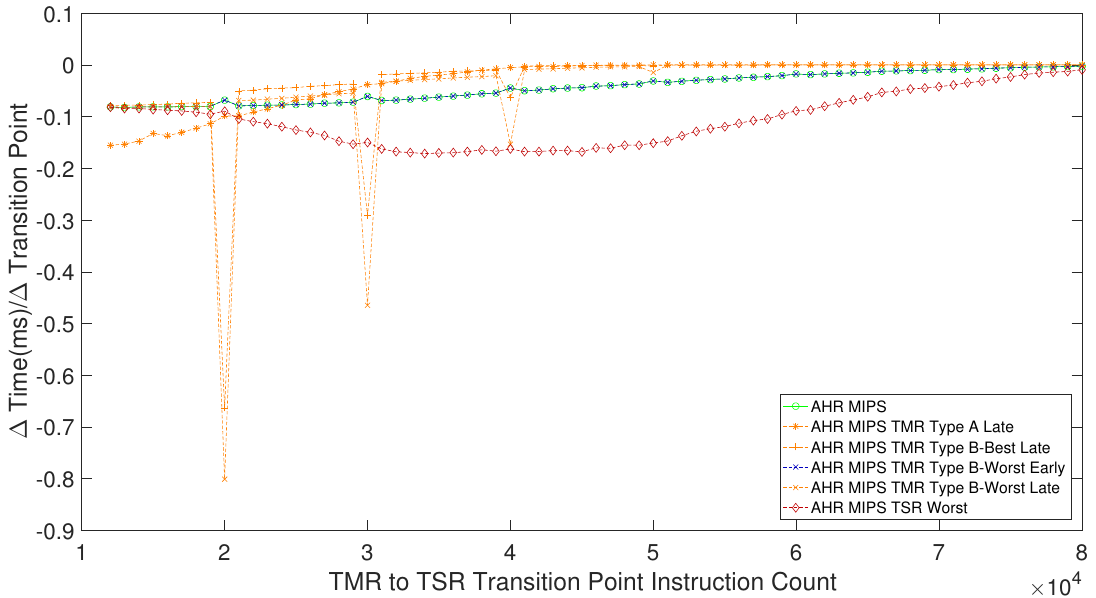
Figure 19. Time Difference Between Successive Steps of TMR to TSR Transition Point When Varying from 11,000 to 80,000 in Steps of